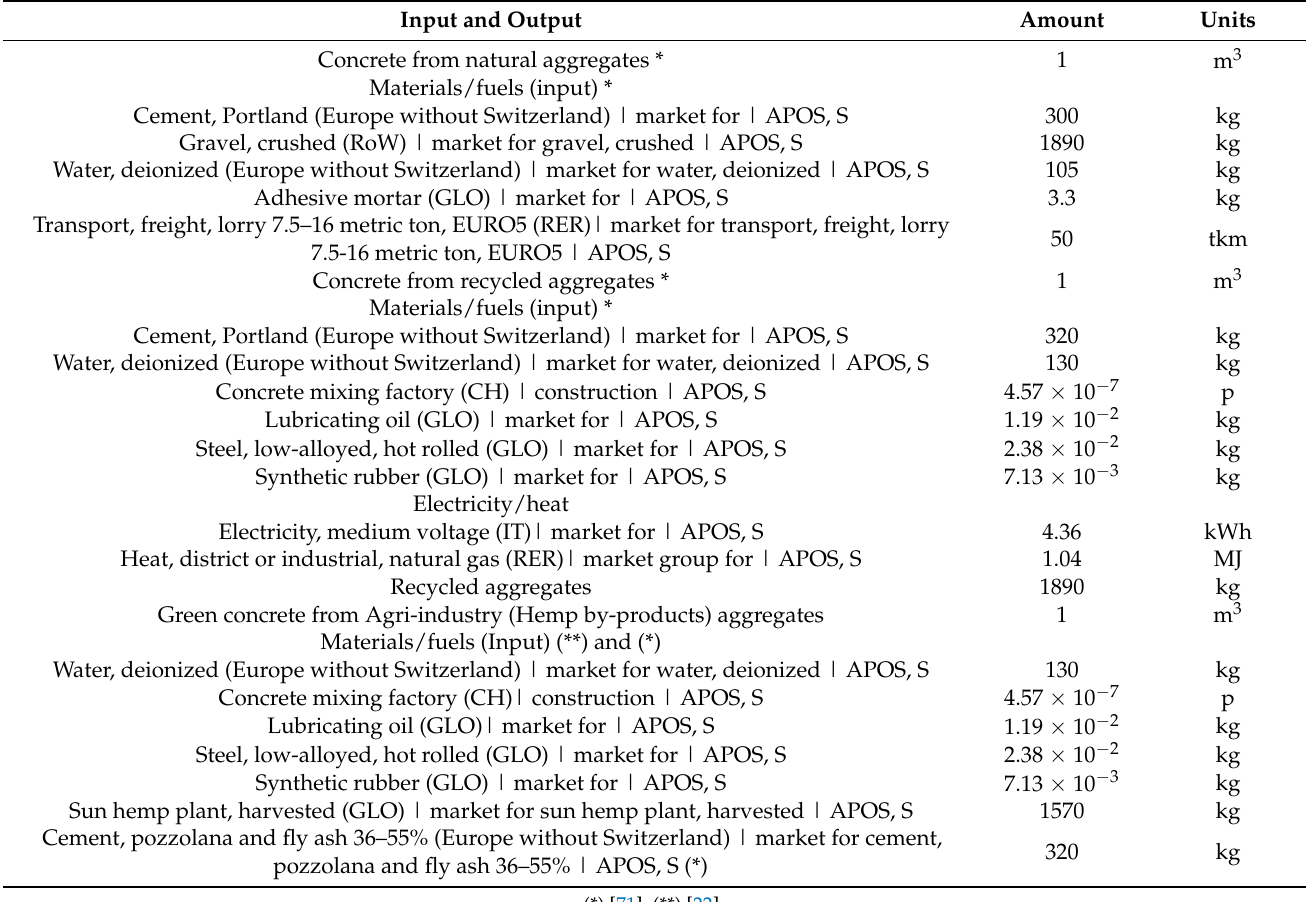
Table 2. Inventory data for the production of conventional concrete and the alternative options made of recycled aggregates and hemp by-products. Input and Output Amount Concrete from natural aggregates * Cement, Portland (Europe without Switzerland) | market for | APOS, S 300 kg Gravel, crushed (RoW) | market for gravel, crushed | APOS, S 1890 kg Water, deionized (Europe without Switzerland) | market for water, deionized | APOS, S 105 kg Adhesive mortar (GLO) | market for | APOS,